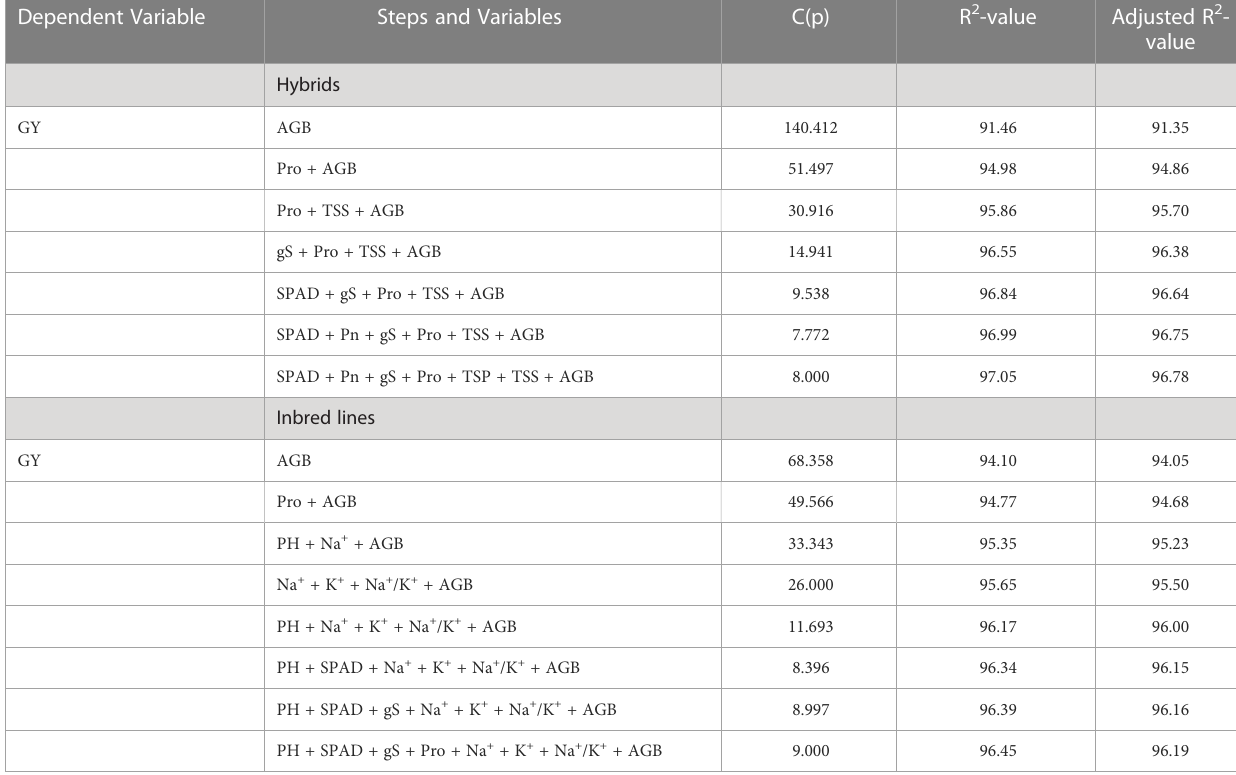
TABLE 5 Traits modeling for salinity tolerance in pearl millet through multiple linear regressions approach. Dependent